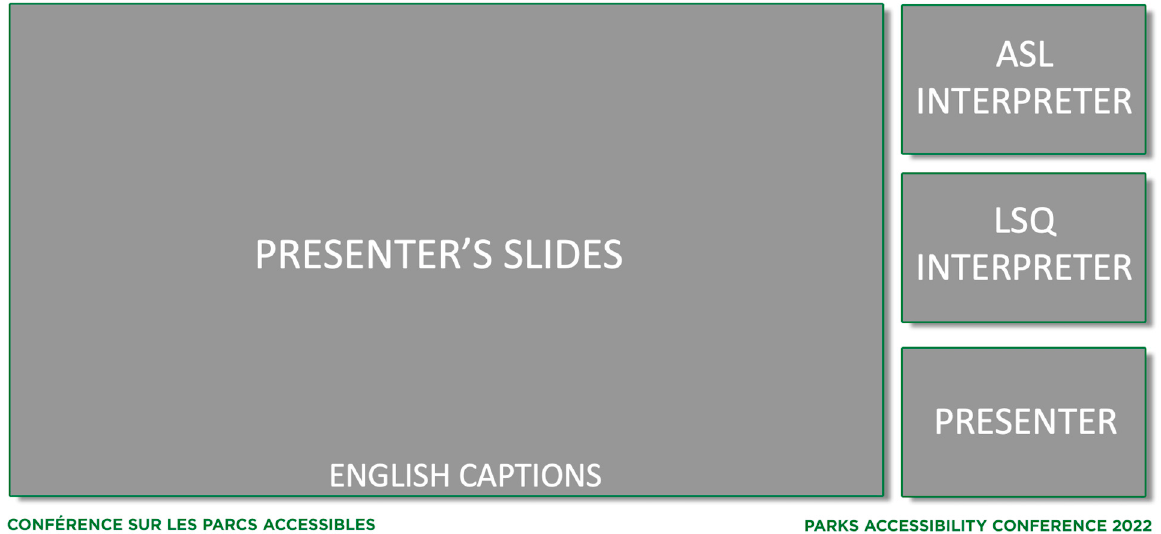
Figure 2. Screen state of the Zoom Webinar for single presenter with presentation slides.